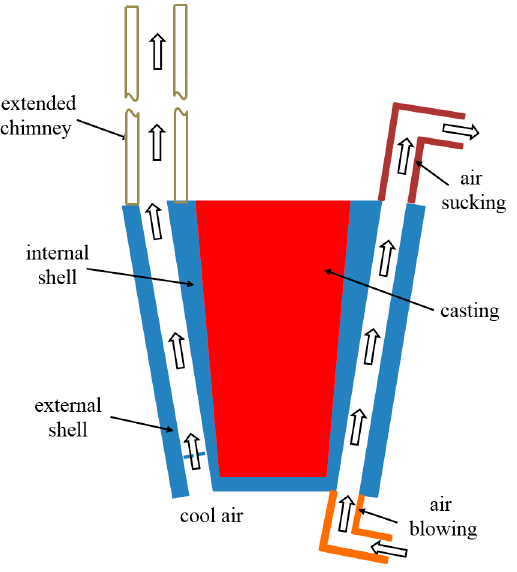
Figure 16. Schematic diagram of the improved chimney structure.